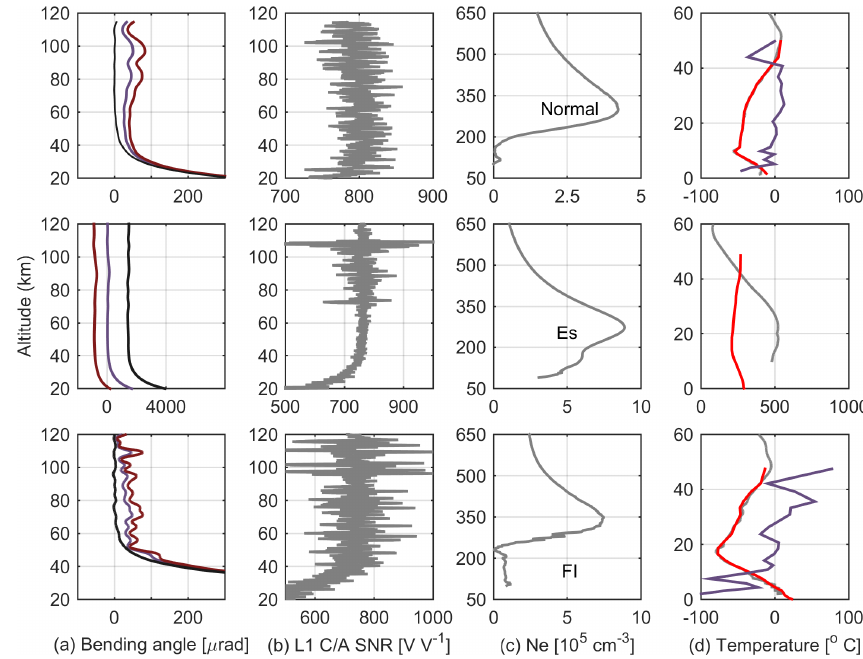
Figure 1. Example of three cases in 2013 made by COSMIC. The panels from top to bottom are normal examples without the ionospheric irregularity occurrence, the E s example, and the F region irregularity example. Panels from left to right are (a) the inverted bending angles, (b) the L1 C/A SNR, (c) the electron density profile at the RO tangent points, and (d) the inverted dry temperature (gray line) versus the ECMWF results (red line). The inverted L1 (purple line), L2 (brown line), and LC (black line) bending angles are all depicted in column (a). The purple lines in column (d) represent the bias between the inverted dry temperature and the ECMWF results multiplied by 10. Please note that the y axis of all panels represents the altitude with kilometer (km) as the